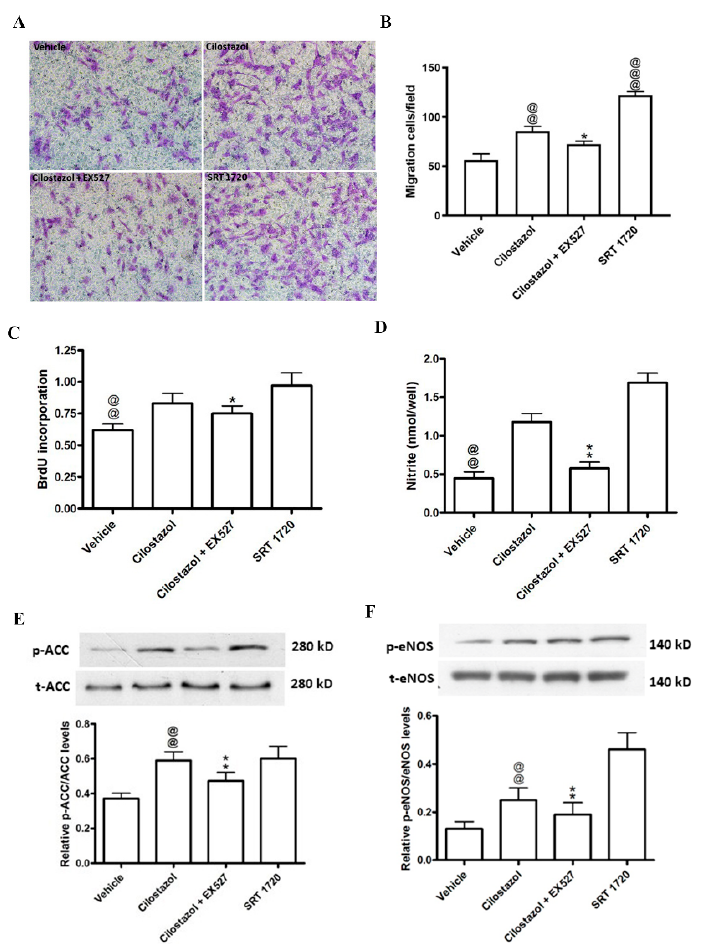
Figure 4. Contributions of SIRT to the cilostazol-induced angiogenic effects on HUVECs pretreated with HG. HUVECs were cultured for 3 days in serum-free M199 containing EX527 (10 µM) and SRT 1720 (0.1 µM) and then cocultured with HASMCs treated with vehicle or cilostazol. ( A ) Representative images (×200) of migrating cells stained with crystal violet. ( B ) Quantification of migrating cells. ( C ) Quantification of BrdU incorporation. ( D ) Nitrite production in HUVECs. ( E , F ) Cell lysates were detected for ACC, p-ACC ( E ), eNOS and p-eNOS ( F ) using Western blot analysis. The results are represented as the mean ± S.E.M. from three independent experiments performed in triplicate. @@ p < 0.01 and @@@ p < 0.001 versus the vehicle group; * p < 0.05 and ** p < 0.01 versus the cilostazol (100 µM) group.